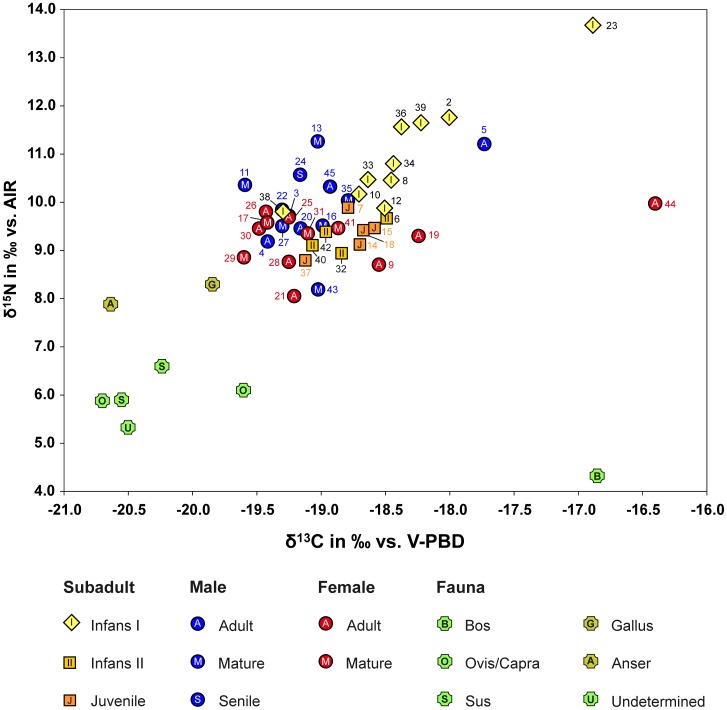
Scatter plot of δ13C and δ15N values of human and faunal collagen from the cemetery at Szólád (graphics: C. Knipper).